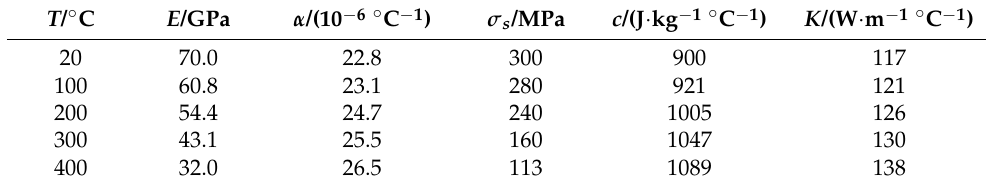
Table 1. Material performance parameters [36].